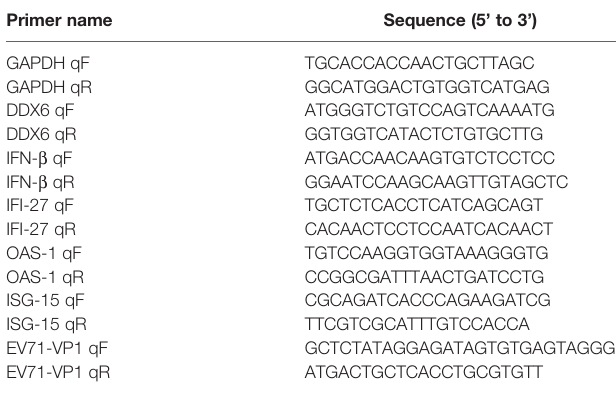
TABLE 1 | The sequences of real-time PCR primer pairs.